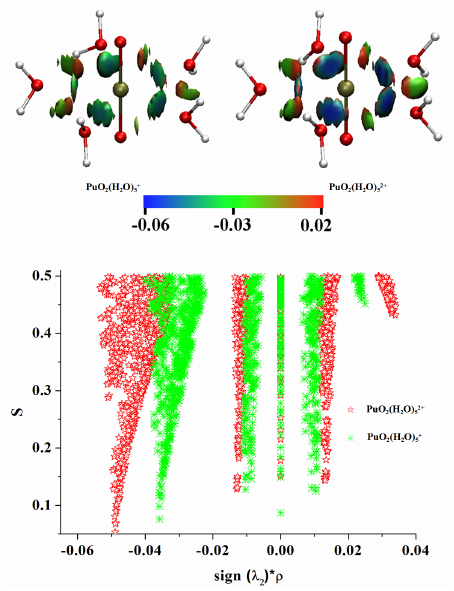
Figure 4. 2D scatter plots of the RDG vs. sign( λ 2 ) ∗ ρ and corresponding 3D isosurfaces were generated with s = 0.5 for PuO 2 (H 2 O) + and PuO 2 (H 2 O) 2 + aquo complexes. 5 5